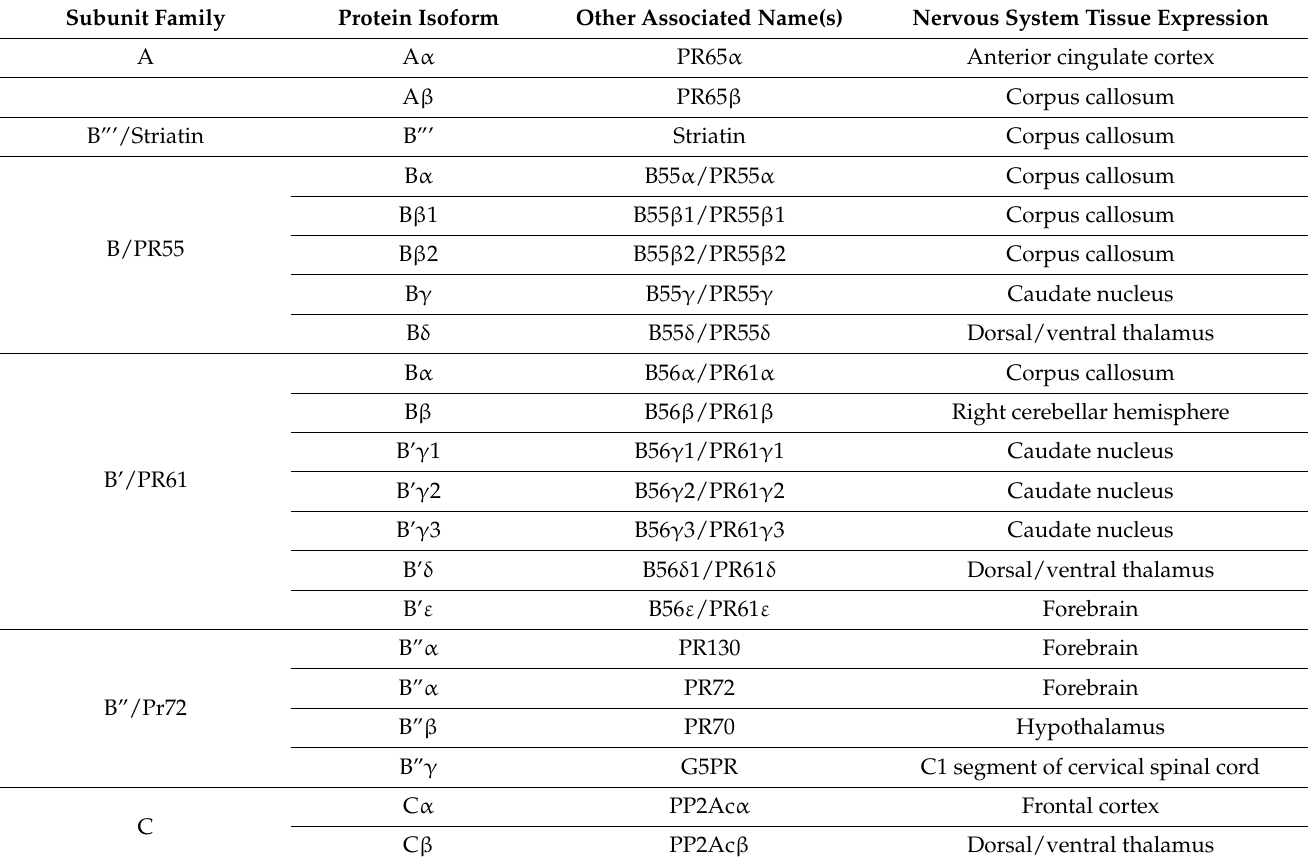
Table 1. List of known PP2A subunits including additional associated names. Nervous system expression represents the highest level of PP2A subunit gene expression in a central nervous system structure. Genetic information was obtained from the UniProt protein sequence database (https://www.uniprot.org/ (accessed on 3 June